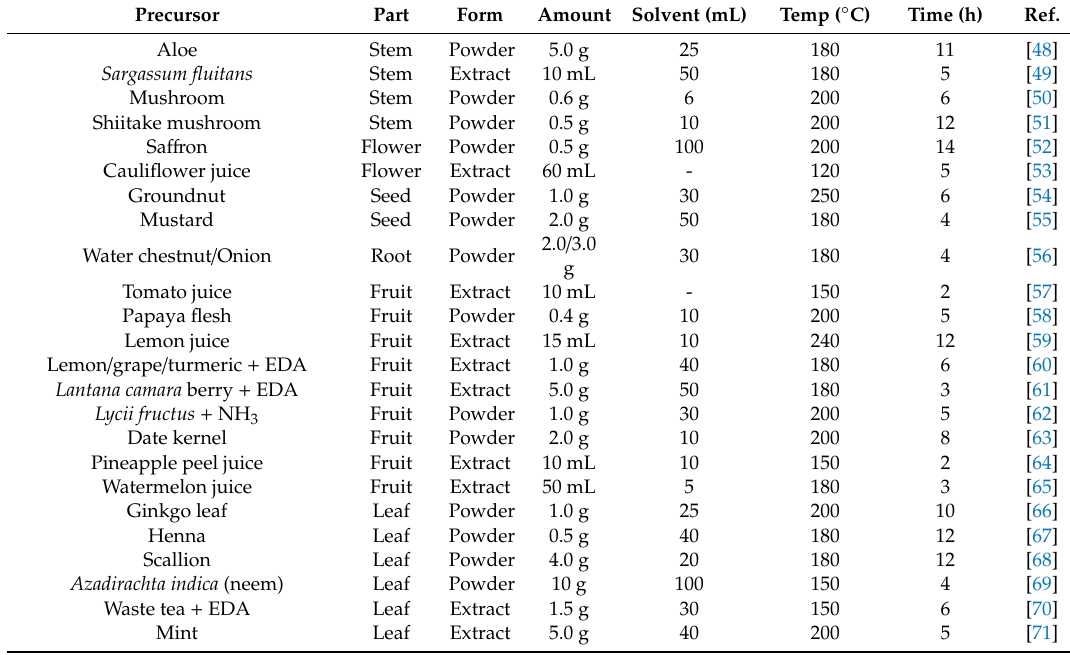
Table 2. The synthesis conditions of plant part-derived CDs through the hydrothermal method. Precursor Part Form Amount Solvent (mL) Temp ( ◦